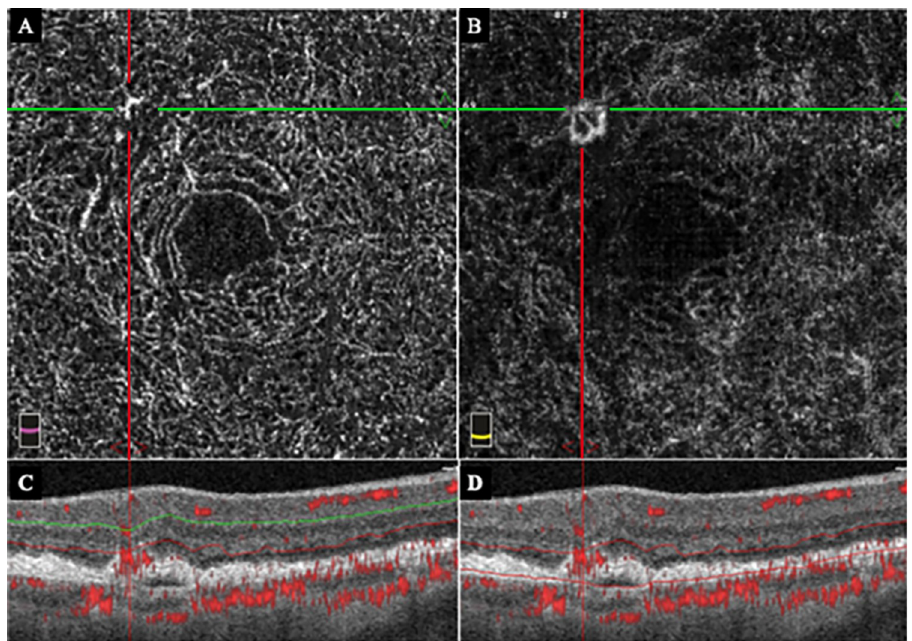
Fig 6. En face OCTA and OCT images at onset of the type 3 MNV of the right eye of the same case shown in Fig 4. A: En face OCTA image of the DCP segment shows abnormal blood pattern in the superotemporal area of the macula located at the intersection of the horizontal (green) and vertical (red) lines. B: En face OCTA image of the OR segment showing abnormal blood patterns in the superotemporal area of the macula located at the intersection of the horizontal (green) and vertical (red) lines. C: B scan OCTA image overlayed with blood information shows the abnormal blood information in the DCP segment. D: B scan OCTA image overlayed with blood information shows the abnormal blood patterns in the OR